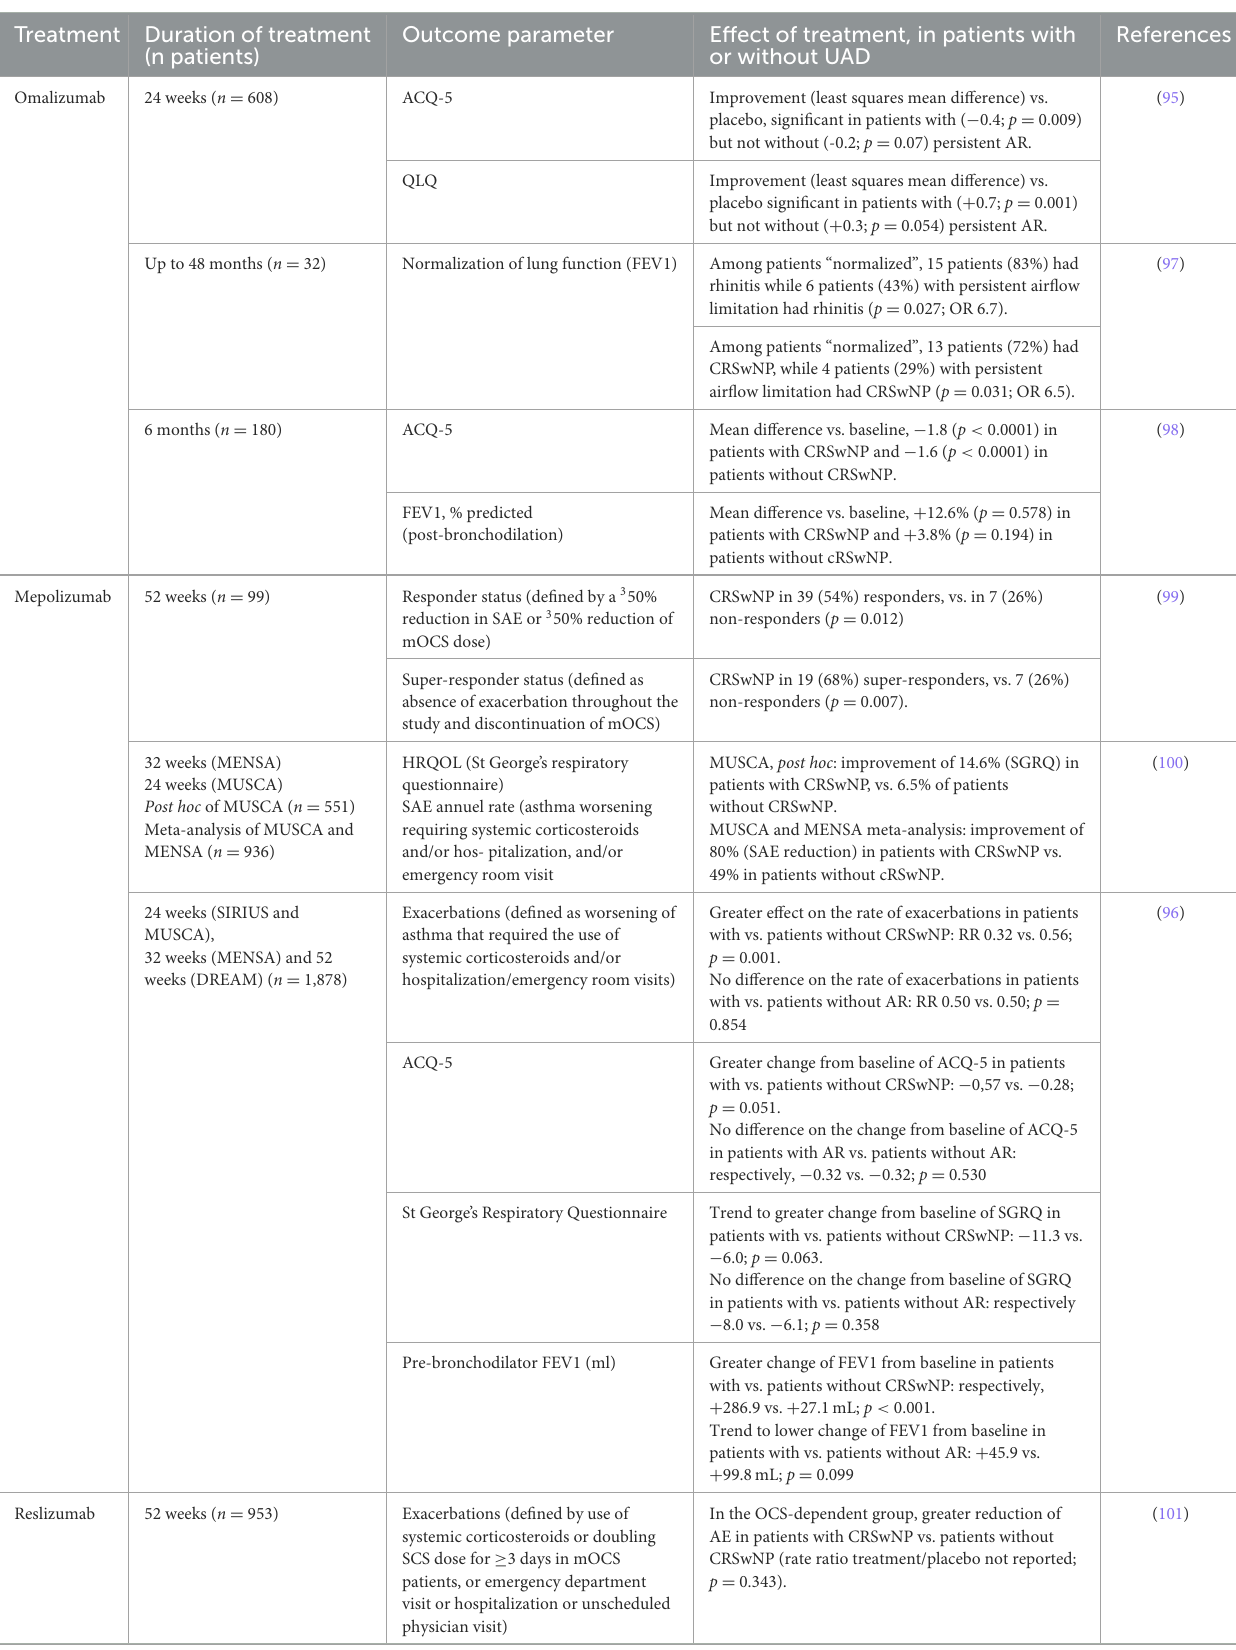
TABLE 1 Predictive value of UAD diagnosis on asthma-related outcomes in post hoc analysis of randomized controlled trials [except ref. (88–90, 96)] with biologics. Treatment Duration of treatment (n